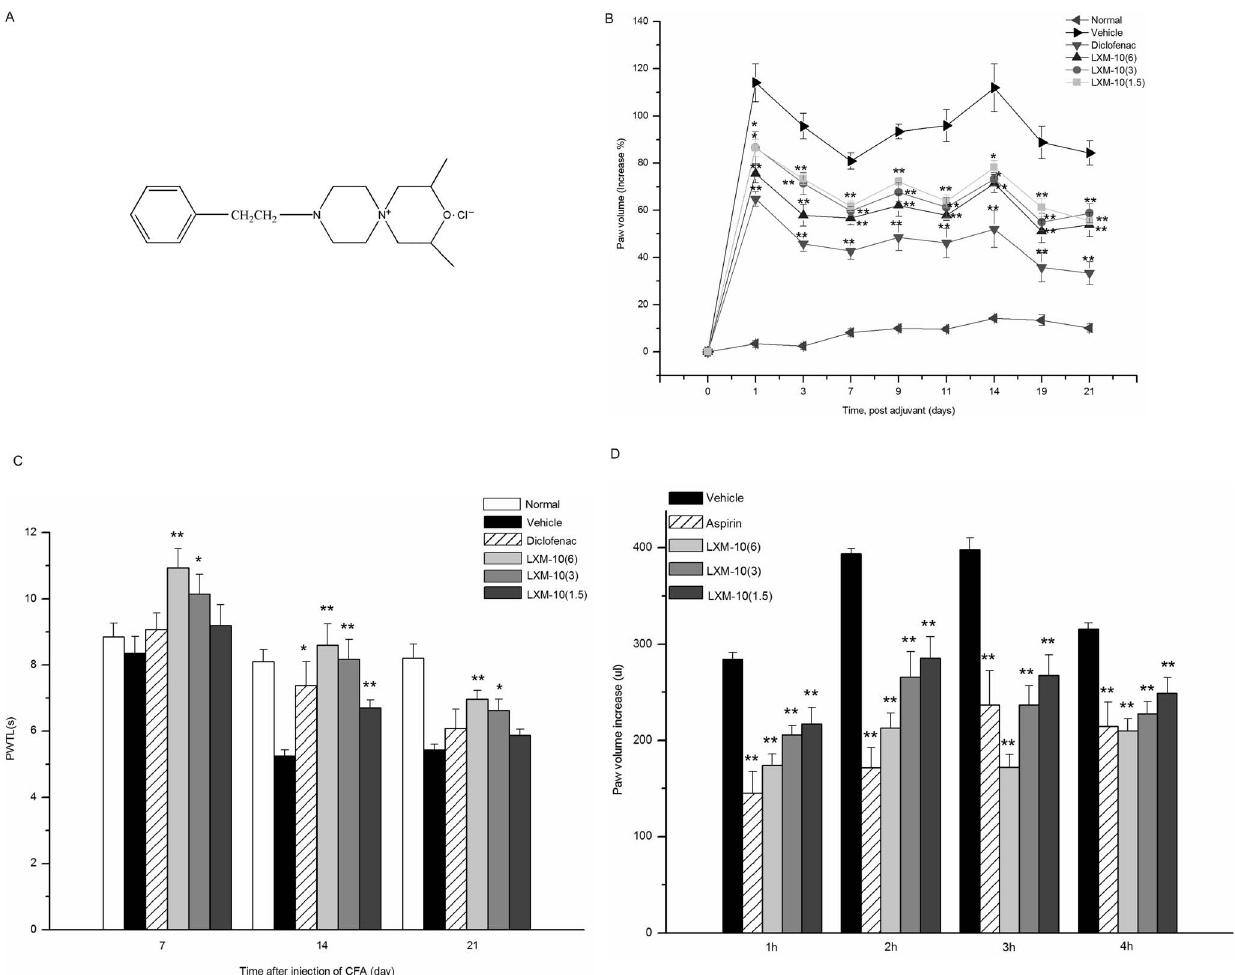
Figure 1. The chemical structure of LXM-10 and its anti-inflammatory effects in vivo. (A) The chemical structure of the spirocyclopiperazinium compound LXM-10. (B) Effect of LXM-10 on complete Freund’s adjuvant (CFA)-induced paw swelling. The rats were administered with LXM-10 (6, 3, 1.5 mg/kg, i.g.), diclofenac (5 mg/kg, i.g.) or vehicle for 21 days after injecting CFA. The paw volume was evaluated on days 0, 1, 3, 7, 9, 11, 14, 19 and 21. All data are mean 6 SEM of 6 rats per group. Significant differences from the vehicle group at the same time are indicated by * P , 0.05 and ** P , 0.01. ( C ) Effect of LXM-10 on complete Freund’s adjuvant (CFA)-induced thermal hyperalgesia. The rats were administered with LXM-10 (6, 3, 1.5 mg/kg, i.g.), diclofenac (5 mg/kg, i.g.) or vehicle for 21 days after injecting CFA. The thermal hyperalgesia were detected on days 7, 14, 21. All data are mean 6 SEM of 6 rats per group. Significant differences from the vehicle group at the same time are indicated by * P , 0.05 and ** P , 0.01. ( D ) Effect of LXM-10 on carrageenan induced paw oedema. The rats were administered with LXM-10 (6, 3, 1.5 mg/kg, i.g.), aspirin (300 mg/kg, i.g.), or vehicle (i.g.) and the paw volume was measured at 1, 2, 3 and 4 h after challenged by carrageenan. All data are mean 6 SEM of 8 rats per group. Significant differences from the vehicle group at the same time are indicated by * P ,